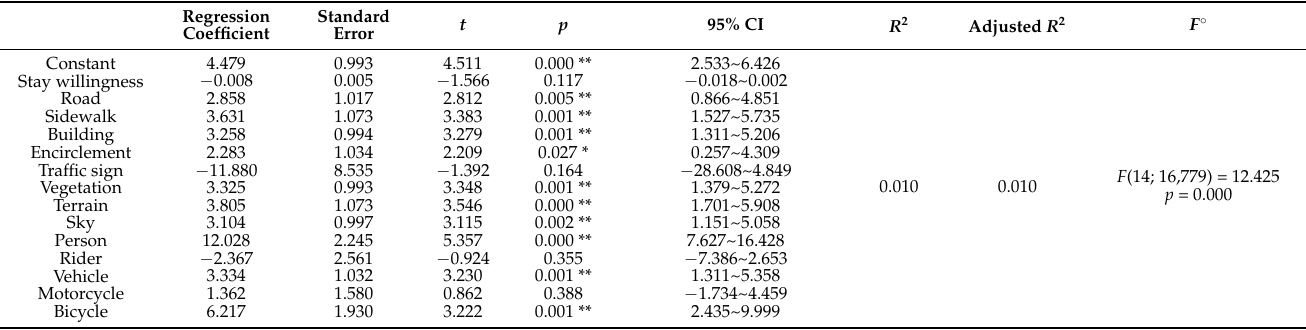
Table 6. OLS analysis with taste rating as the dependent variable ( n = 16,794).